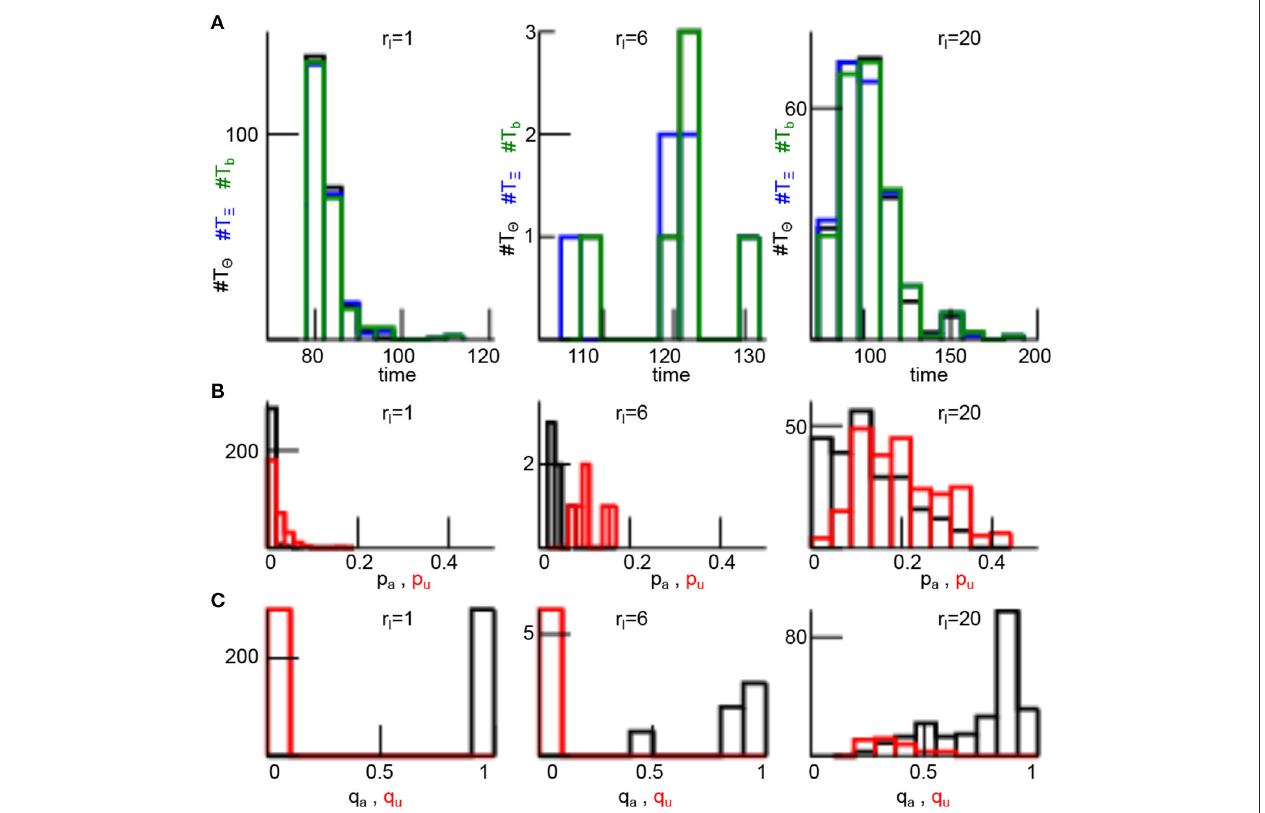
FIGURE 8 | Divergence times and ensemble member alignment dependent on the localization radius r l . (A) Histogram of time of maximum 2 n ( T 2 , black), time of maximum 4 n ( T 4 , blue), and the divergence time T b (green) , see the Methods section 2.8 for definitions. (B) Histograms of alignment ratio p a (black) and anti-alignment ratio p u (red) defined in Equation (26). (C) Histograms of alignment ratio q a (black) and anti-alignment ratio q u (red) defined in Equation (28). In addition r H 5 and results are based on the 200 numerical trials from Figure 4 . =